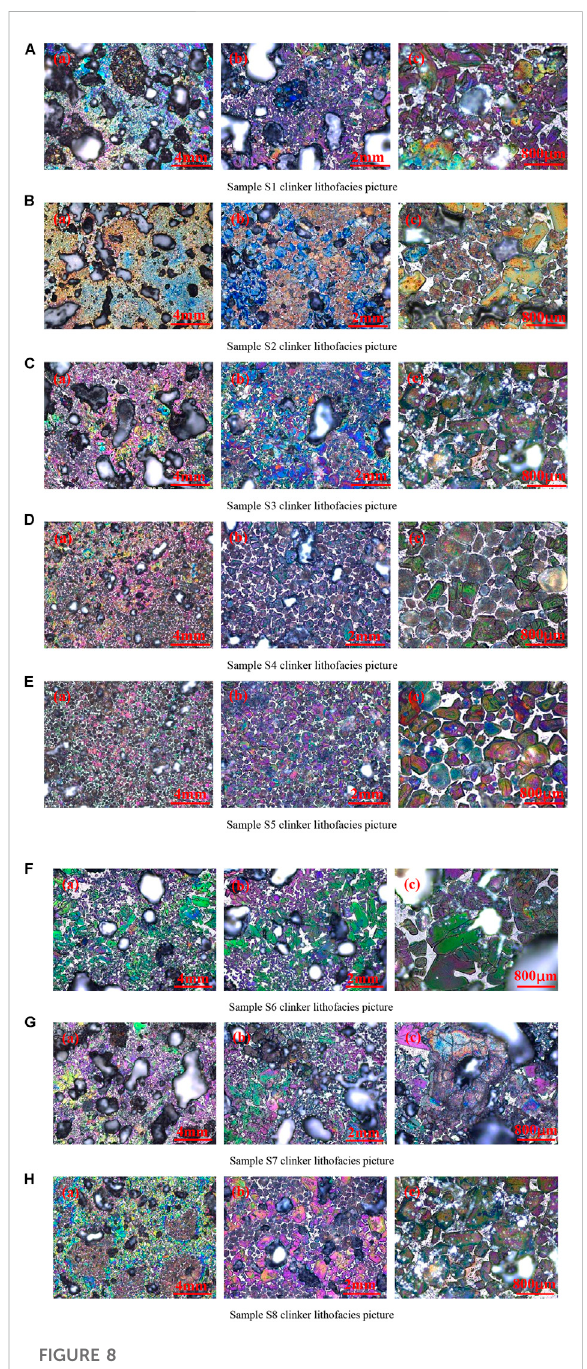
FIGURE 8 The lithofacies pictures of different cement clinker